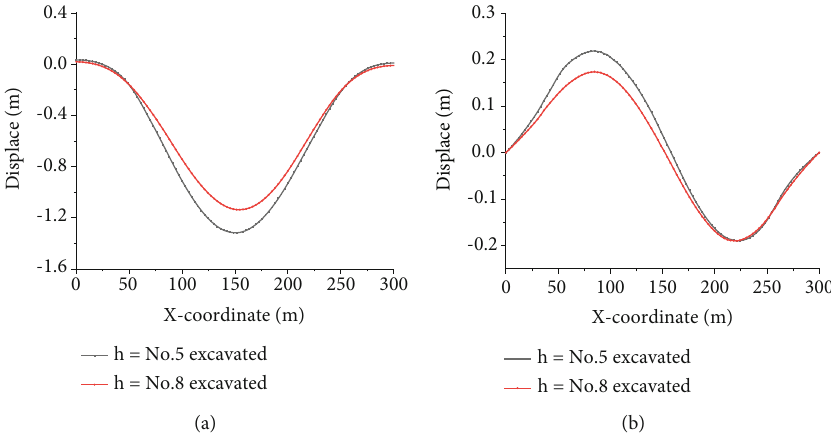
Figure 11: Ground deformation curves: (a) ground vertical displacement; (b) ground horizontal